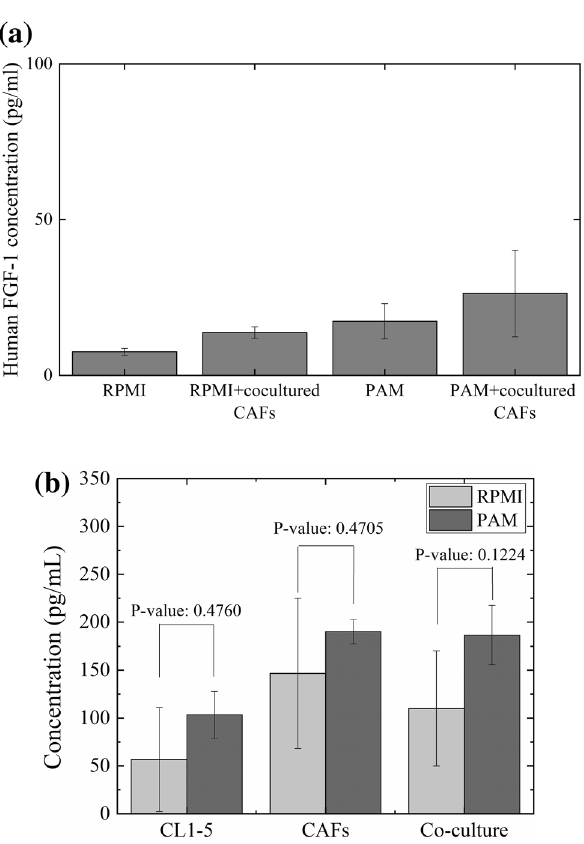
Figure 11. CL1–5 cells were cultured individually or cocultured with CAFs and treated with normal RPMI medium or PAM. The FGF-1 ( a ) and TGF-β1 ( b ) concentration in conditioned medium was analyzed using an FGF-1 ELISA kit. Data are mean and SD values (n = 3). (Student’s t